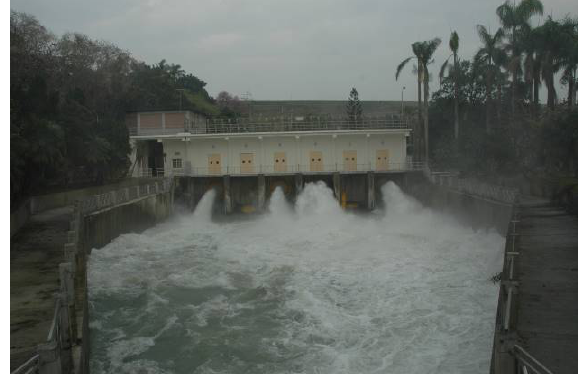
Figure 3. One of the facilities in the Jianan Irrigation